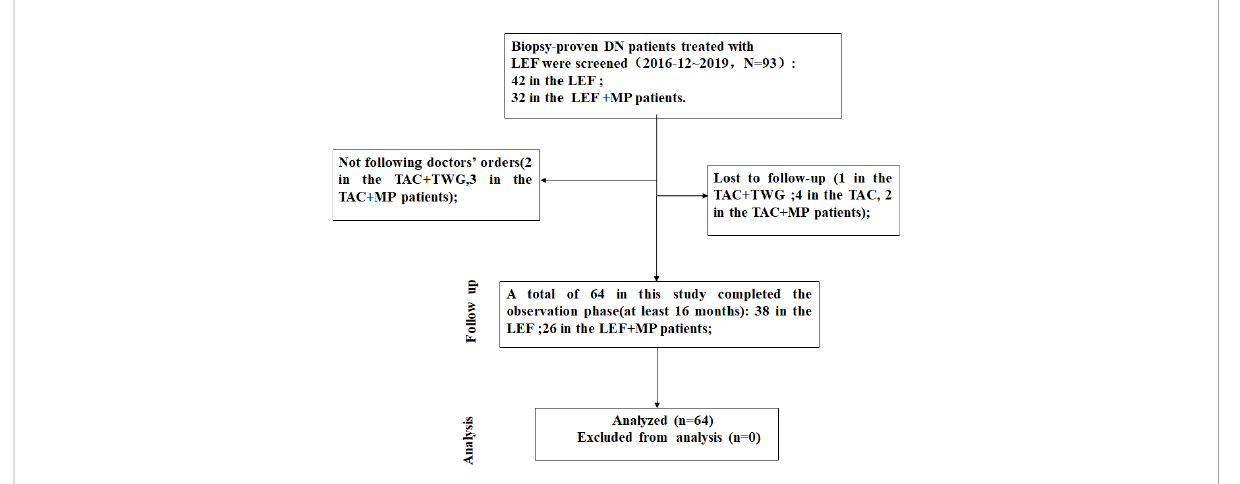
FIGURE 1 The screening process. We collected the clinical data of 74 patients with biopsy-con fi rmed DKD combined with MN. Ultimately, a total of 64 patients completed the study, 38 in the LEF group and 26 in the LEF+MP